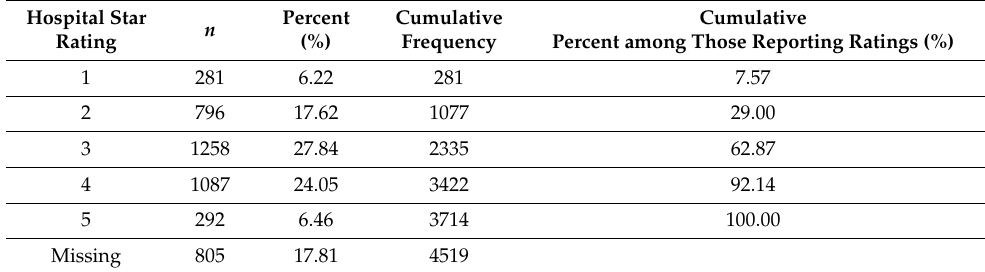
Table 1. Summary of hospitals’ overall quality star